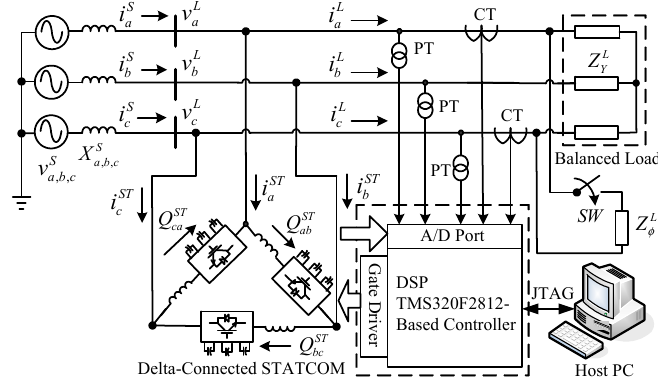
Figure 9. STATCOM hardware test system.